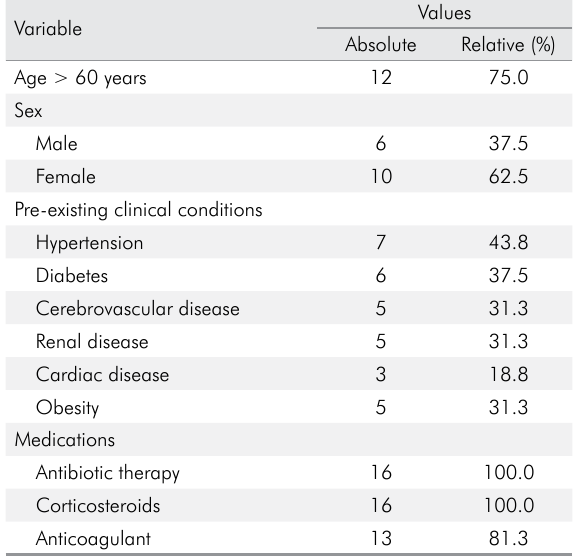
Table 1. Clinical characteristics and treatment of patients with COVID-19 included in this case